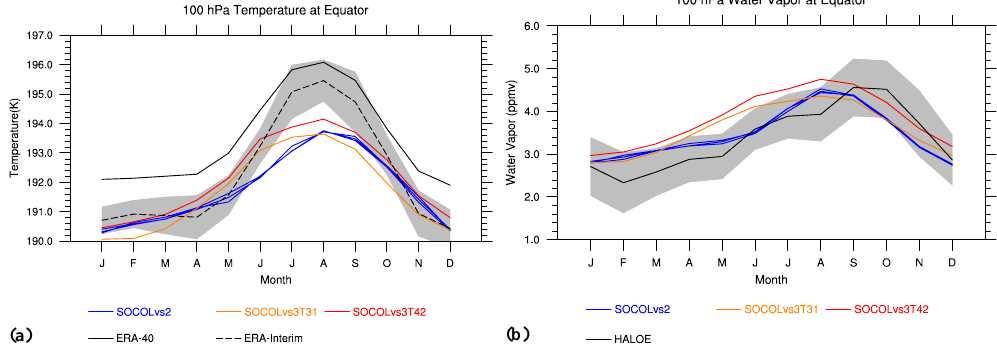
Fig. 5. Seasonal variation of the climatological mean temperature (a) and H 2 O (b) at 100hPa at the Equator, for SOCOLvs2 (blue lines), SOCOLvs3 T31 horizontal resolution (orange line), SOCOLvs3 T42 horizontal resolution (red line), ERA-40 (solid black line) and ERA-Interim (dashed black line, grey shading ± 1 σ , 1992–2001), and HALOE observations (solid black line, grey shading ± 1 σ , 1992–2001).